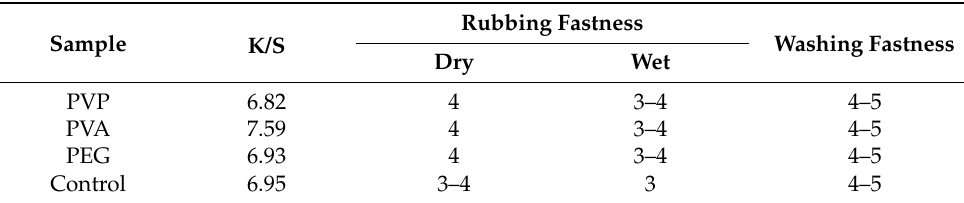
Table 4. Color yield and color fastness of the printed polyester fabric using disperse dye inks with different additives and control sample.